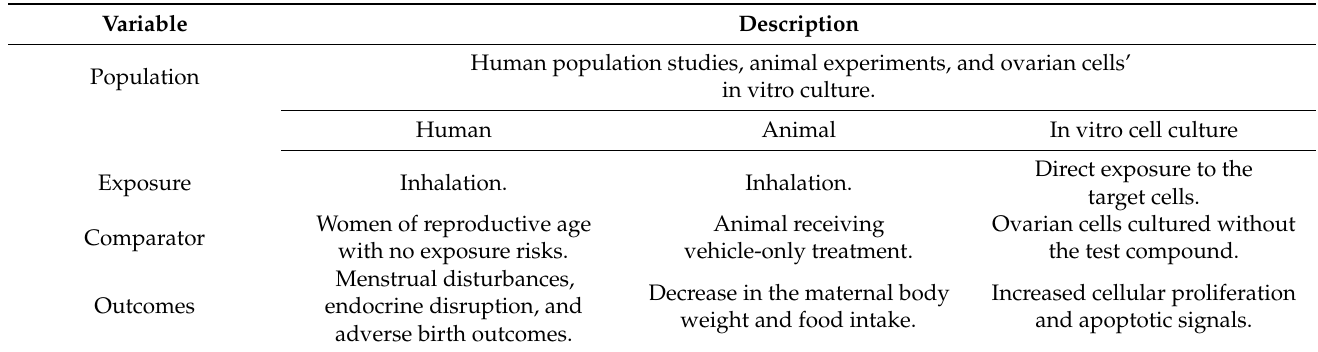
Table 2. PECO (population, exposure, comparator, and outcome) model.